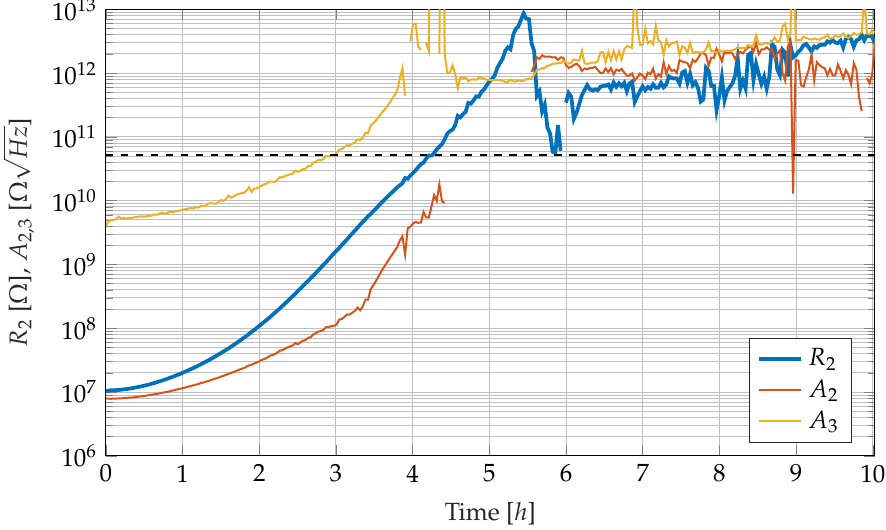
Figure 9. Course of the fitted parameters R 2 (blue, middle curve), A 2 (red, lower curve) and A 3 (yellow, upper curve) describing ion conduction and electrode polarisation. The dashed line indicates the upper border of the confidence range for the parameter R 2